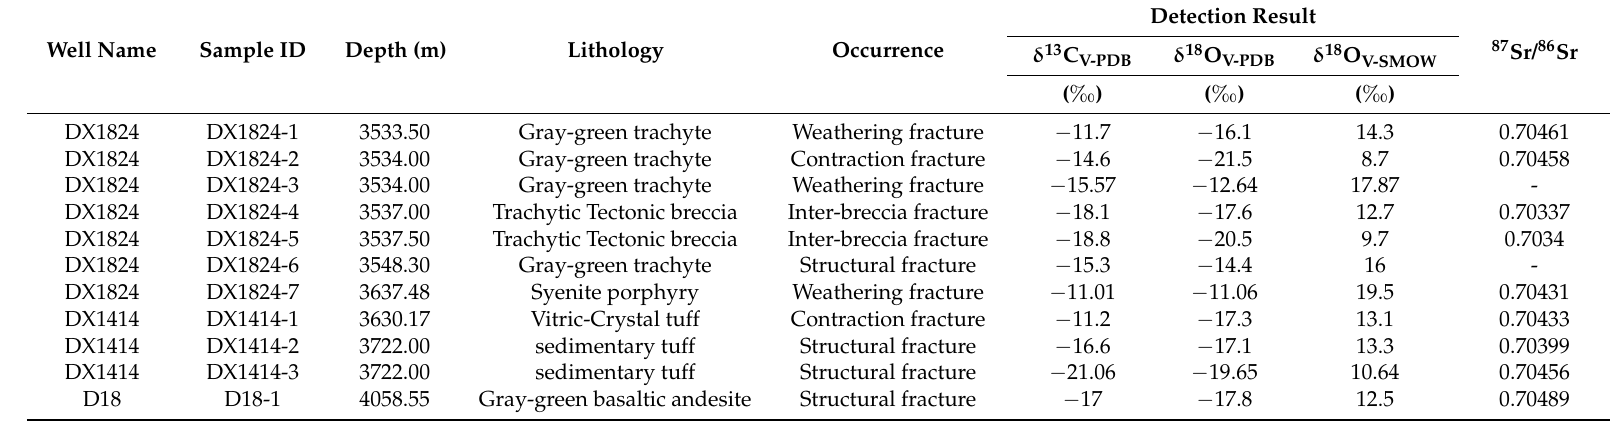
Table 4. Carbon, oxygen, and strontium isotopic compositions of calcite veins in the hosted Carboniferous igneous reservoirs in the Dixi